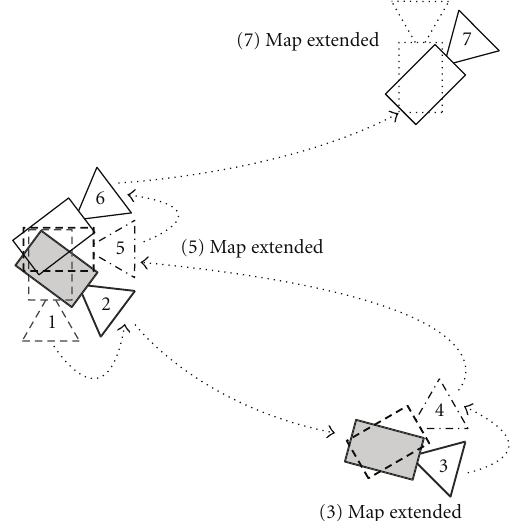
Figure 8: Map building with the new keyframe addition. Camera successive positions where new keyframe is added are numbered from 1 to 7. (1) PTAMM after stereo initialization, (2) camera rotated to point into part of the scene without initialized features, (3) camera moved forward to obtain stereo separation, keyframe added, and new features initialized, (4) camera rotated again to look at another uninitialized part of the scene, (5) camera moved back for stereo, new features added, and so